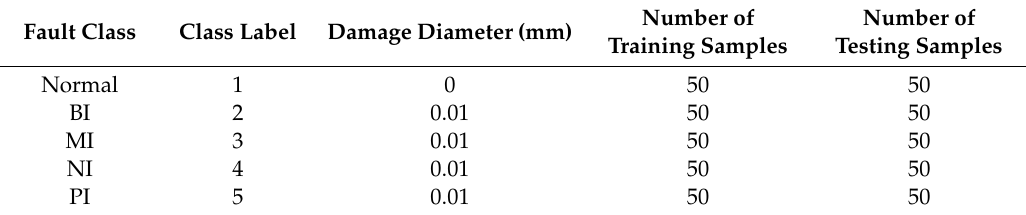
Figure 15. The time domain waveforms of rotating machinery in Experiment 2: ( a ) health condition (Normal), ( b ) broken tooth in the driving tooth with inner race fault (BI), ( c ) missing tooth in the driving tooth with inner race fault (MI), ( d ) health tooth in the driving tooth with inner race fault (NI), ( e ) pitting in the driving tooth with inner race fault (PI).